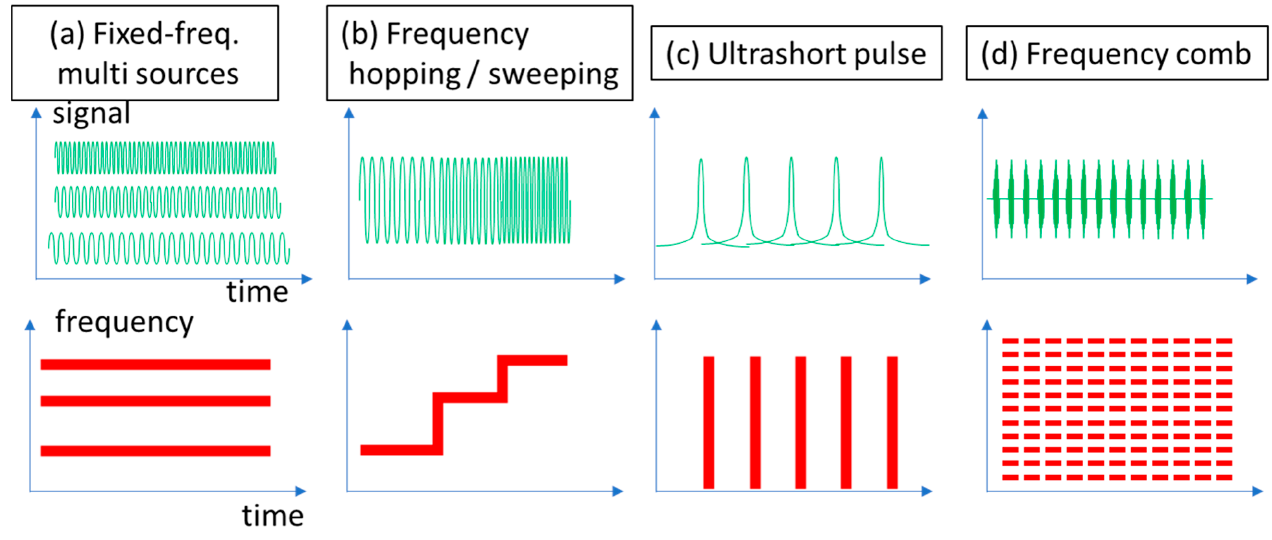
Figure 1. Schematic diagram of various methods of multi-frequency reflectometer technology. Images of temporal behavior of output signal wave forms (green) and frequencies (red). ( a ) Different fixed frequency sources method utilizes independent continuous wave with different frequency components. ( b ) Frequency hopping or frequency sweeping method utilizes time varying frequencies. ( c ) Ultrashort pulse method utilizes a train of impulse which has broadband frequency component. ( d ) Frequency comb method utilizes simultaneous discrete frequency components.